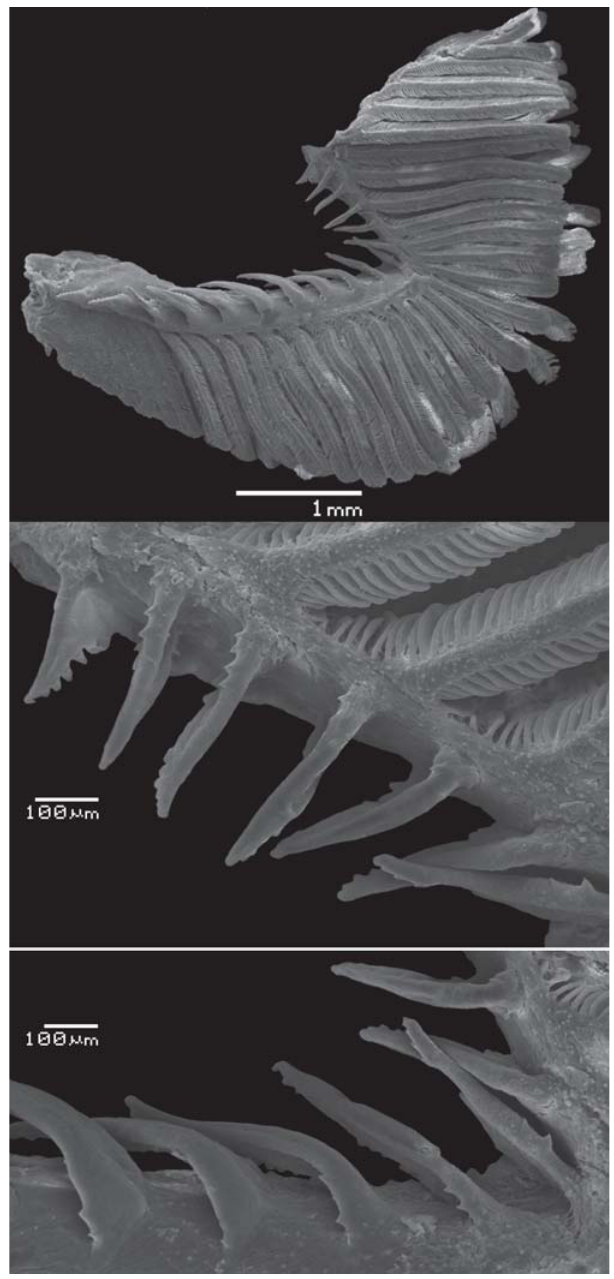
Fig. 3. First gill arch of Odontostilbe fugitiva , MCP 35777, male 35.7 mm SL. SEM photographs of the first left side gill arch showing gill gland (top), in detail gill rakers on upper branchial branch (middle), and gill rakers on lower branchial branch (bottom). Lateral